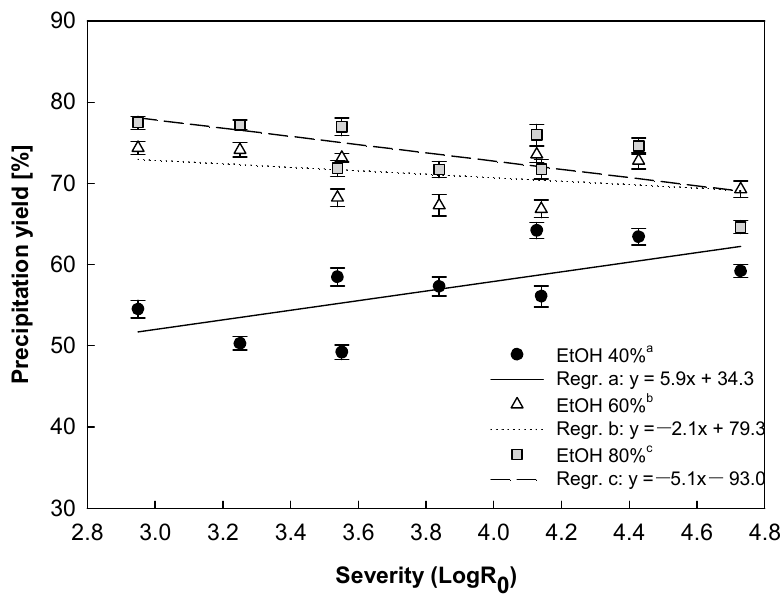
Figure 2. Lignin precipitation yield based on reaction severity (log R 0 from 2.95 to 4.73) and ethanol concentration. Reaction conditions: 150 °C, 170 °C, and 190 °C for temperature; 30 min, 60 min, and 120 min for time; and 40%, 60%, and 80% for ethanol concentrations; solid:liquid = 1:10; 0.25 wt.% sulfuric acid concentration.